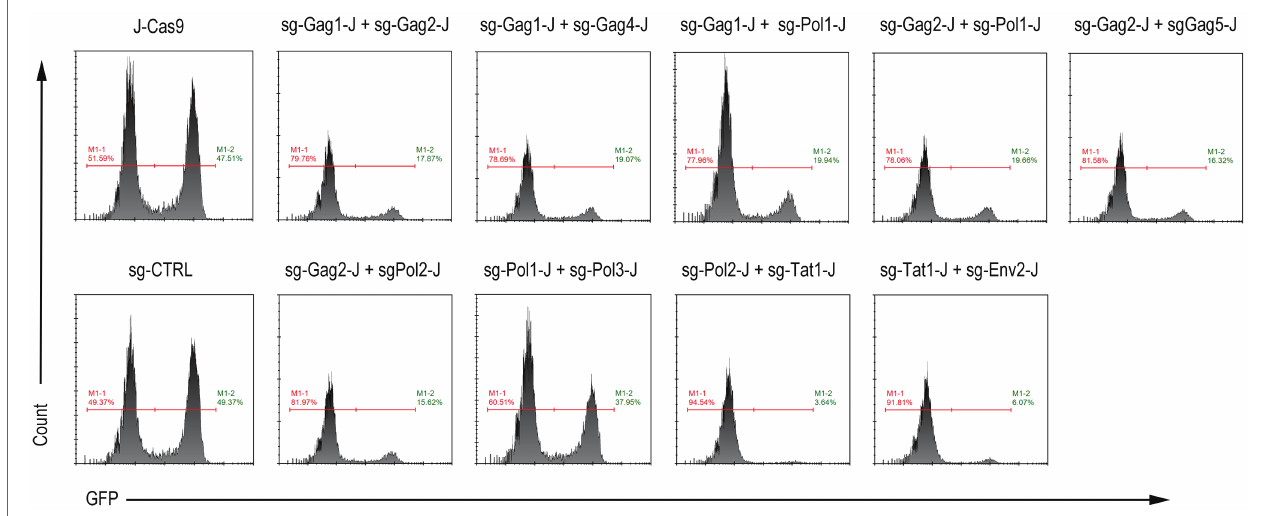
FIGURE 5 | Activation of latent HIV-1 expression in J-Lat 10.6 cells expressing Cas9 and dual-sgRNAs. M1-2 represents the percentage of GFP-positive